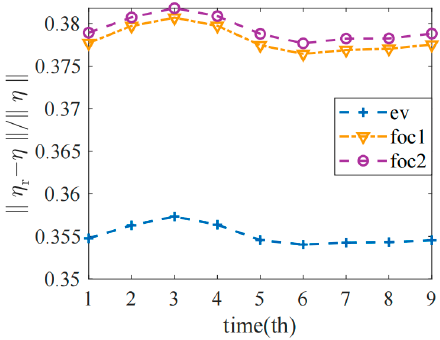
Figure 6. Boundary potential changes in the standard model and the optimized models during a cardiac cycle.